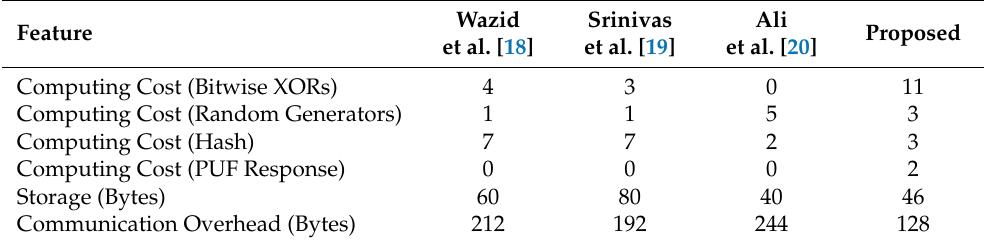
Table 5. Performance comparison of various UAV authentication